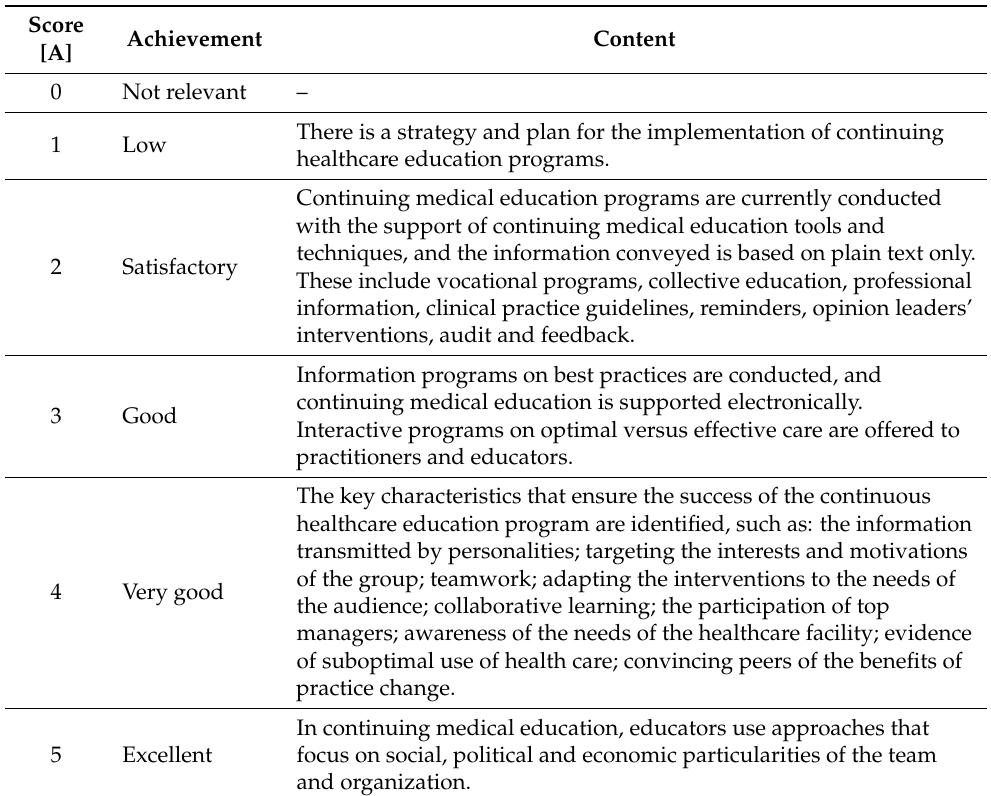
Table A6. Scale for indicator IA31—Continuous healthcare